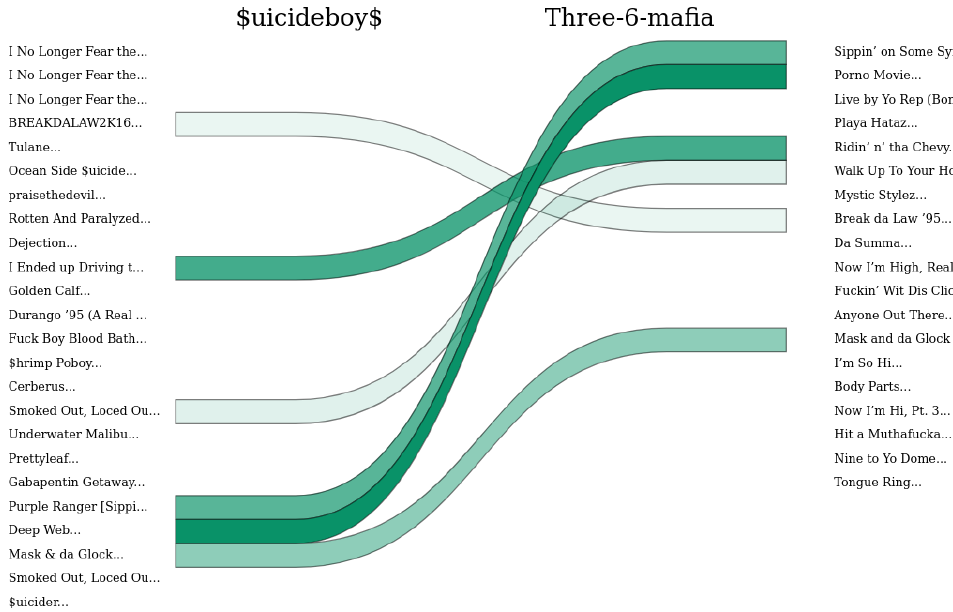
Figure 6. Excerpt of the song level of $uicideboy$ and Three 6 Mafia. All connected songs show cases where $uicideboy$ reused lines from Three 6